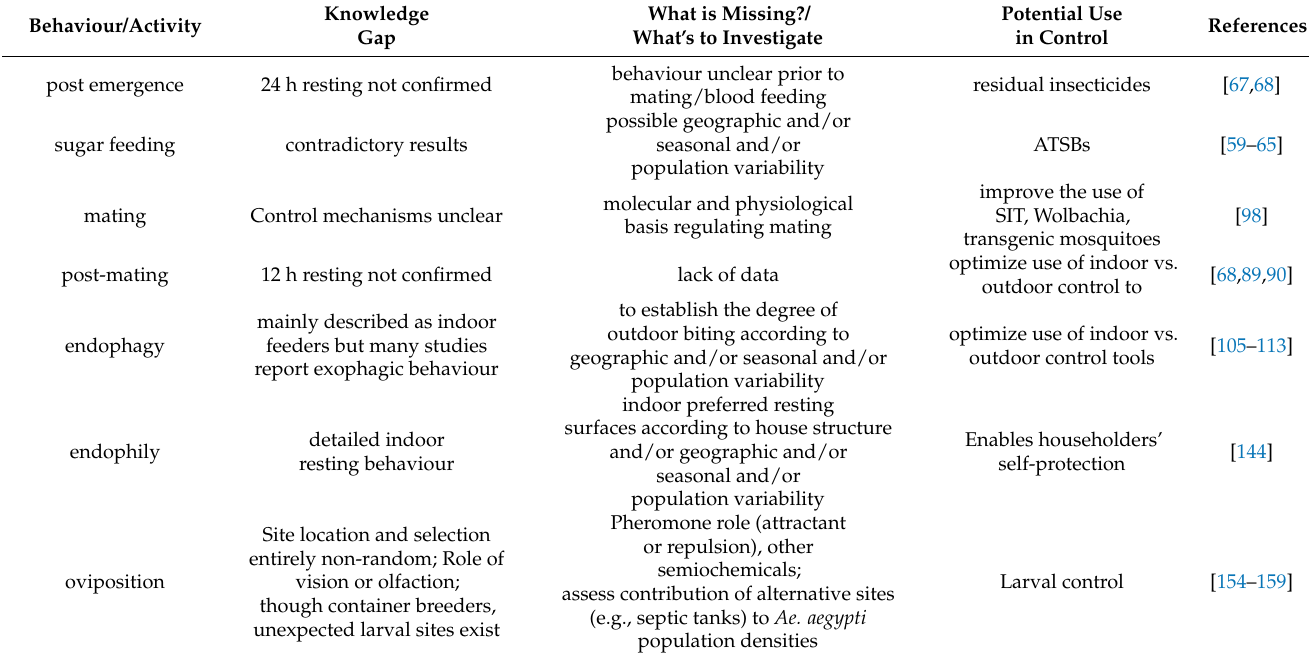
Table 1. Table showing topics for which little is known, or where there is disagreement among experts or where this review’s authors consider the topic likely to be a rich area for exploration. The numbers in the right column refer to the number of the appropriate article in the reference list of this